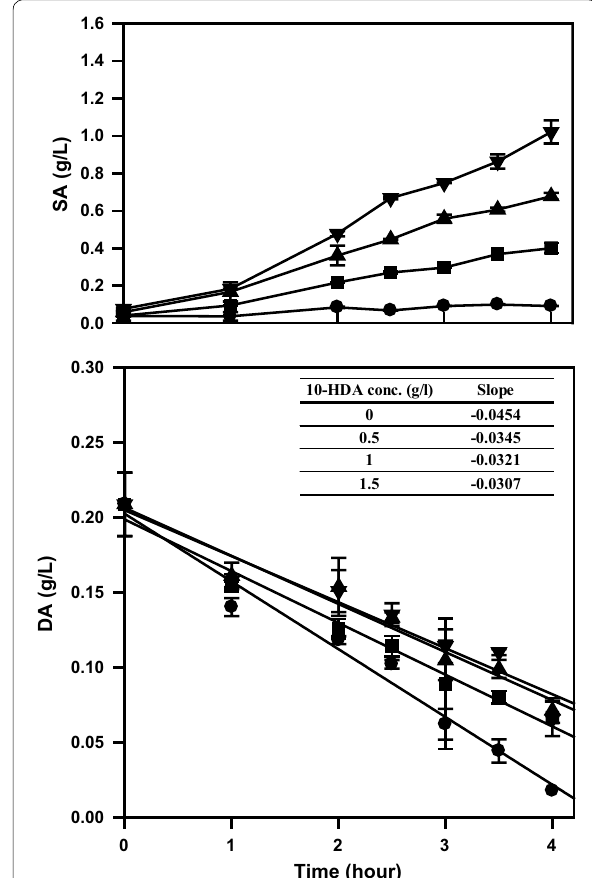
Fig. 3 Effects of 10-hydroxydecanoic acid concentration on decanoic acid oxidation. Error bars represent standard deviation of two inde- pendent runs. Substrates: : DA (0.2 g/L); : DA (0.2 g/L) and 10-HDA (0.5 g/L); : DA (0.2 g/L) and 10-HDA (1 g/L); : DA (0.2 g/L) and 10-HDA (1.5